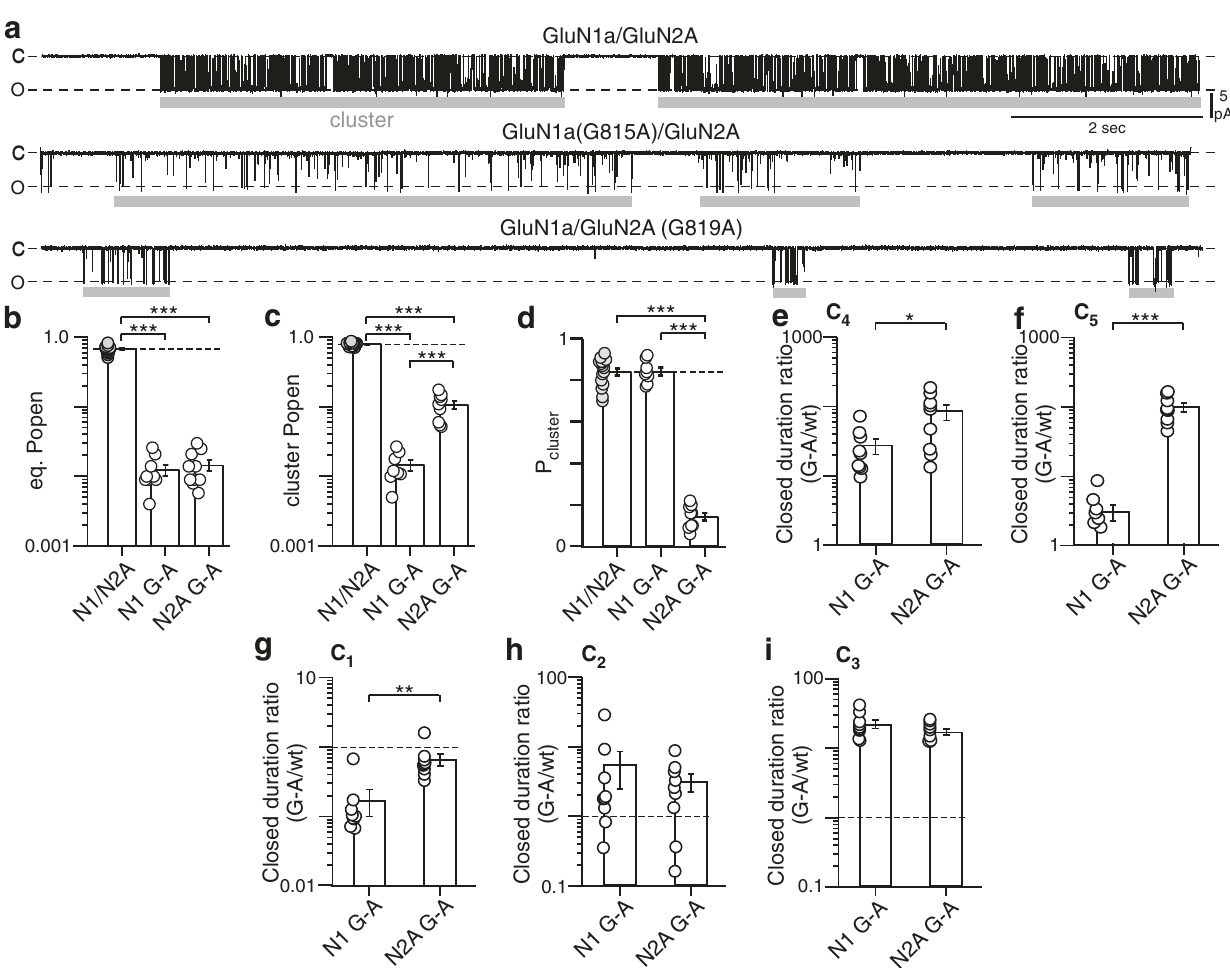
components, C 4 ( e ) and C 5 ( f ) and for the three fastest components, C 1 ( g ), C 2 ( h ), and C 3 ( i ) (Supplementary Fig. 2). The dashed line is 1, which represents no effect relative to wild-type.** p <0.01, *** p <0.001,one-wayANOVA with post-hocTukey ’ s test( b – d )ortwo-tailedStudent ’ s t test,unpaired( e – i ). b ANOVA( p